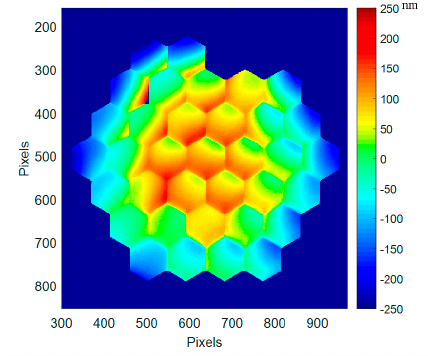
Figure 11. Best flat mirror deformation at cryo (160 K), first run, with the original best flat calibrated at ambient (86 nm RMS, 501 nm PtV).